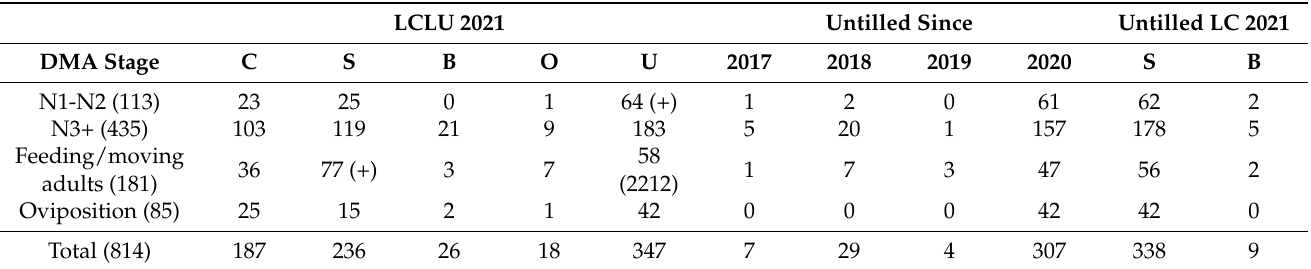
Table 1. Distribution of DMA locations among different classes of 2021 and untilled land evolution 1 . Pearson standardized residuals measuring the deviation from expected values are reported in brackets (+ = positive deviation; − = negative deviation).